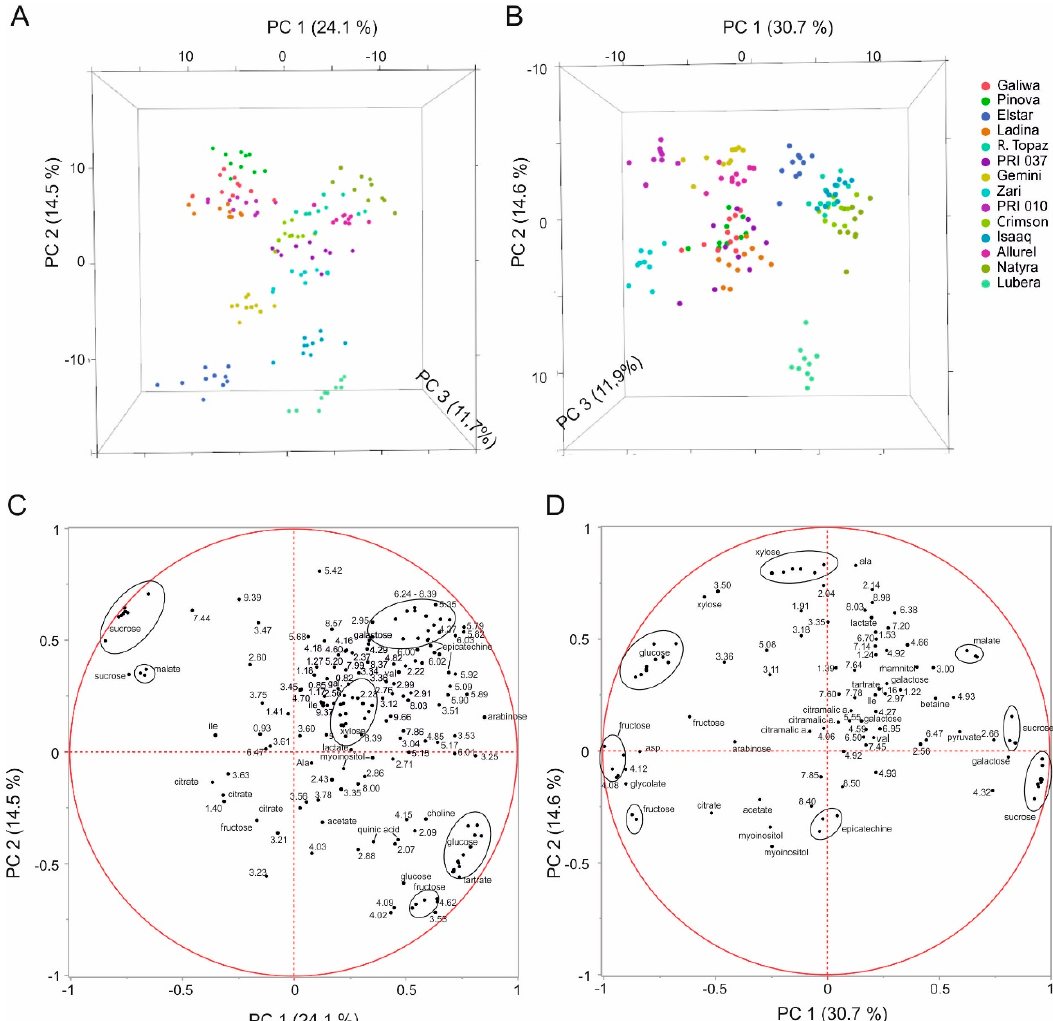
Figure 2. Principal component analysis (PCA) of peel ( A ) and pulp ( B ). ( A,B ) Scores plot showing three PCs (principal component) with their respective variation. Peel: R 2 X (PC1) = 24.1%, R 2 X (PC2) = 14.5%, R 2 X (PC3) = 11.7%, Q 2 (PC1) = 21.4%, Q 2 (PC2) = 15.3, Q 2 (PC3) = 1.7. Pulp: R 2 X (PC1) = 30.7%, R 2 X (PC2) = 14.6%, R 2 X (PC3) = 11.9%, Q 2 (PC1) = 28.9%, Q 2 (PC2) = 12.1, Q 2 (PC3) = 11.0. ( C,D ) Corresponding loadings plot. Loadings are labeled with substance name or ppm value. In case of overlapped resonances, only the ppm value is given.